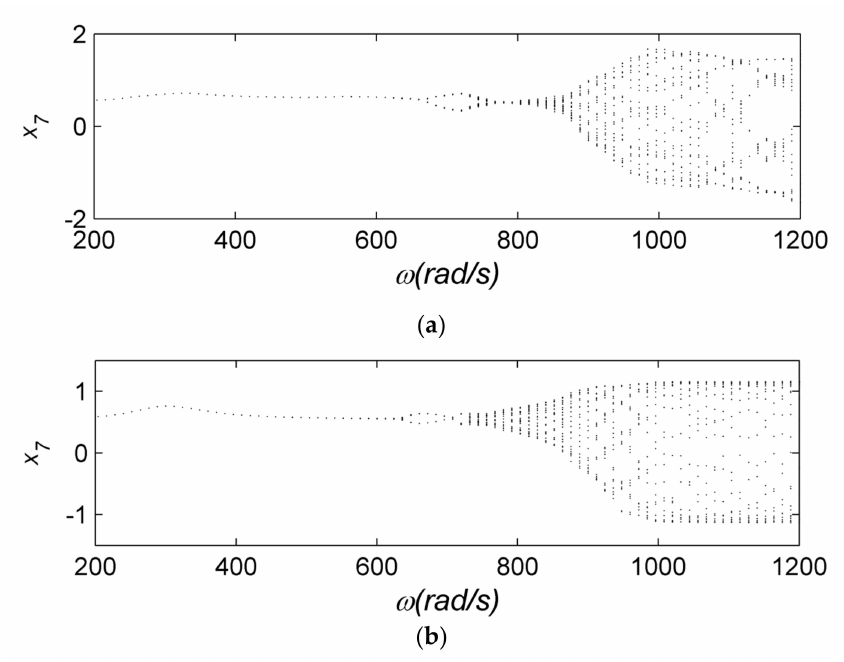
Figure 23. Bifurcation diagrams. ( a ) The original system. ( b ) The reduced